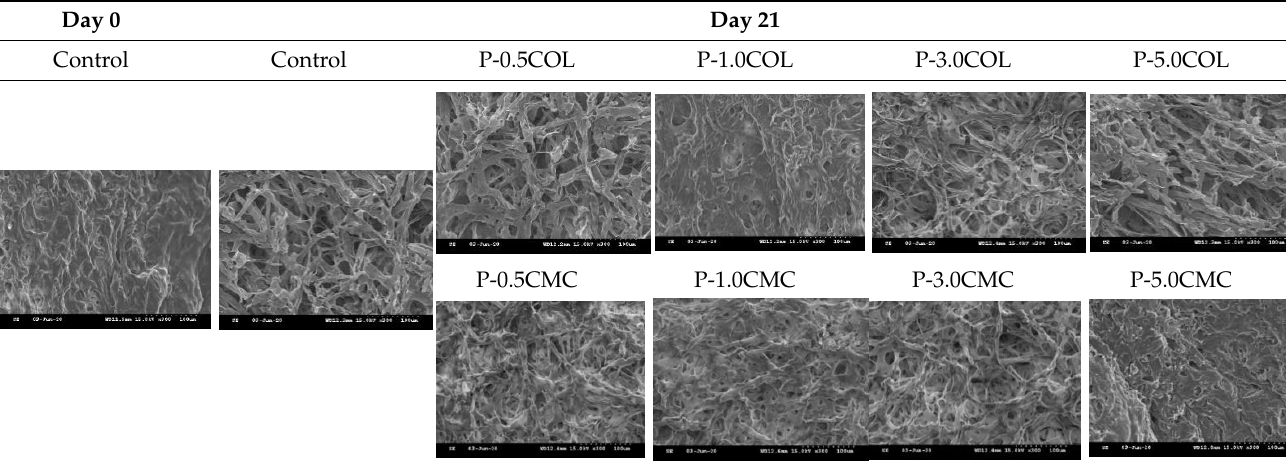
Table 2. Effects of different packaging on the microstructure ( × 1000) in A. bisporus after storage at 4 ◦ C for 21 days.